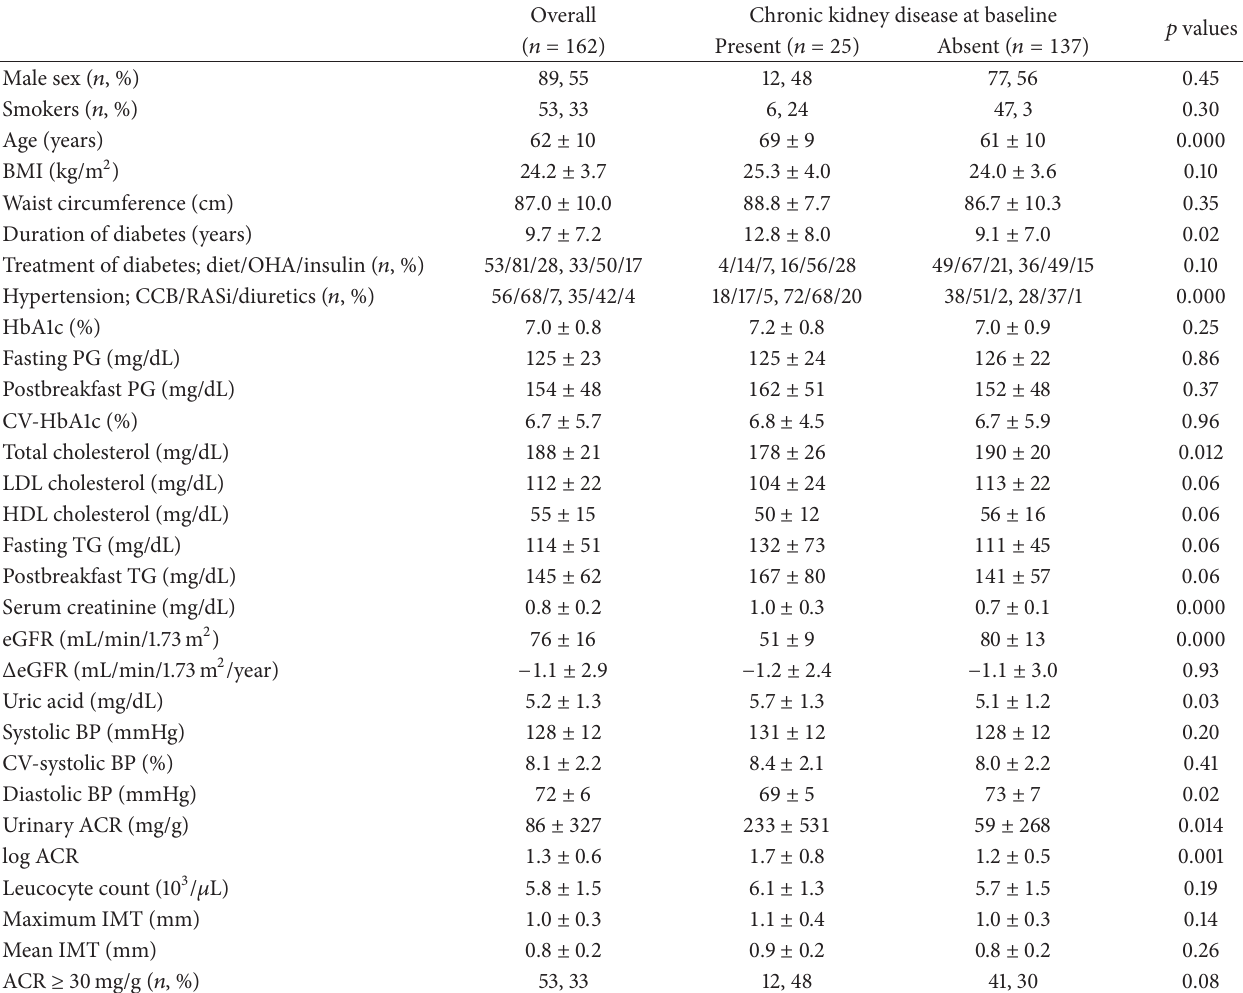
Table 1: Baseline characteristics of 162 patients with type 2 diabetes who had and did not have chronic kidney disease at baseline.